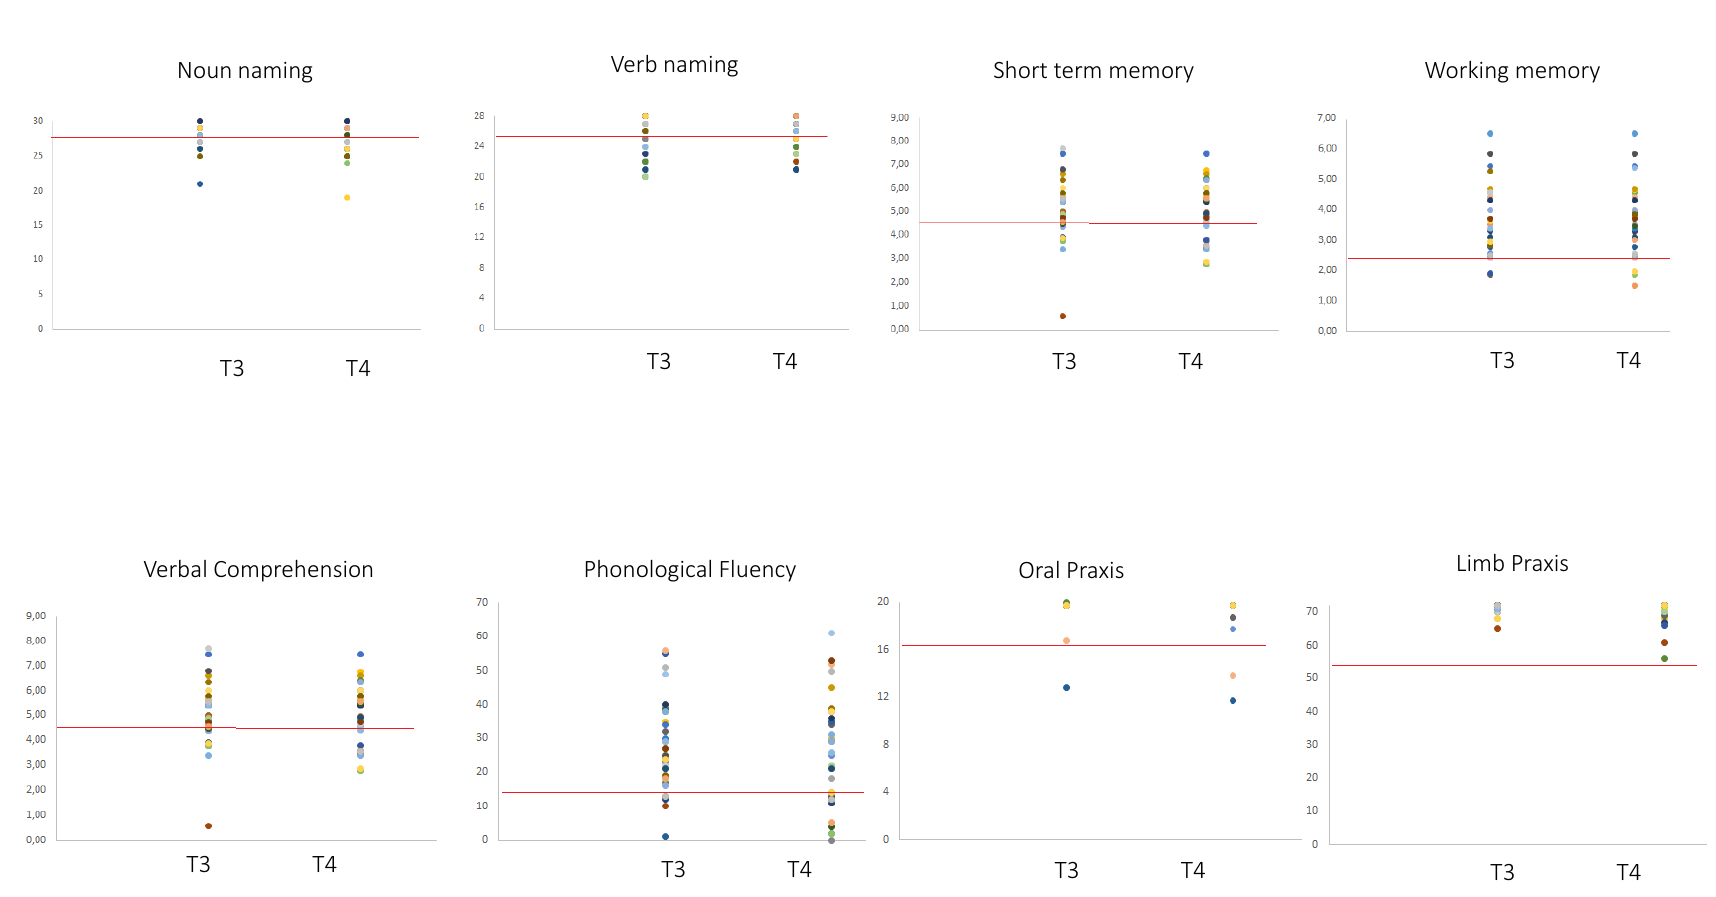
Figure 3. Performance of the 40 patients with recurrent glioma at T3 and T4 (pre- and post-recurrence surgery, respectively). Red lines indicate the cut-o ff , below which the patient results were pathological: verbal short-term memory ( < 4.26 is equal to an equivalent score of 0), working memory ( < 2.65 is equal to an equivalent score of 0), ideomotor limb apraxia ( < 53) [25] and oral apraxia ( < 16) [26], language comprehension ( < 26.25 is equal to an equivalent score of 0) [27], object naming and action naming ( < 28 and < 26 respectively) [28], and verbal fluency ( < 16 is equal to an equivalent score of 0) [29]. Patients showing identical scores are represented by overlapping